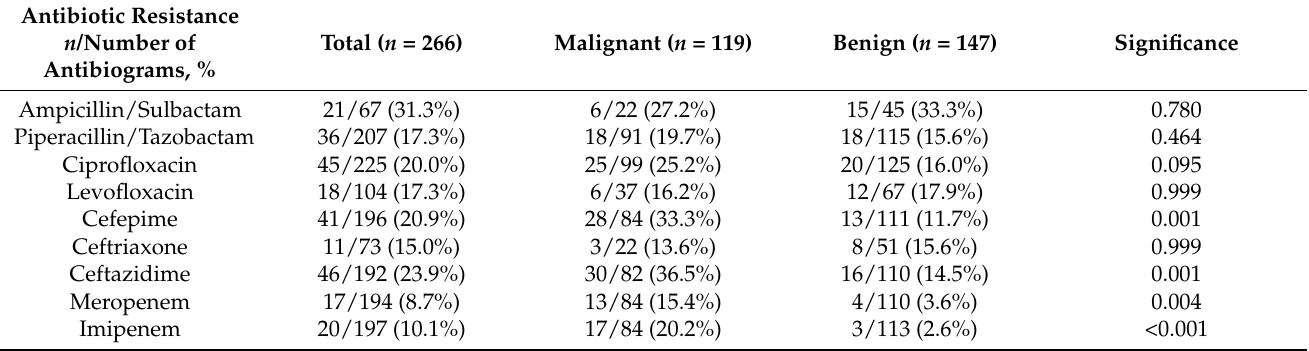
Table 6. Evaluation of antibiotic resistance from bile culture, comparing malignant and benign obstructions in acute cholangitis